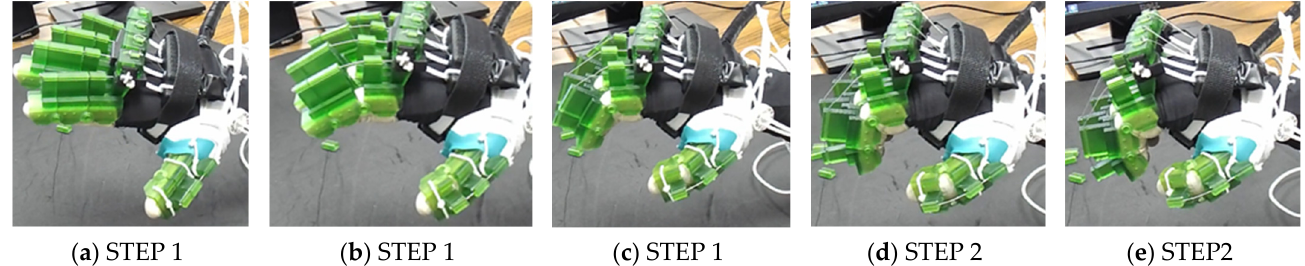
Figure 20. DIP, PIP, and MCP flexion of fingers and thumb: ( a ) all joints are extended, joint angles: 0 ◦ ; ( b – d ) intermediate joint positions; and ( e ) all joints are at flexed.